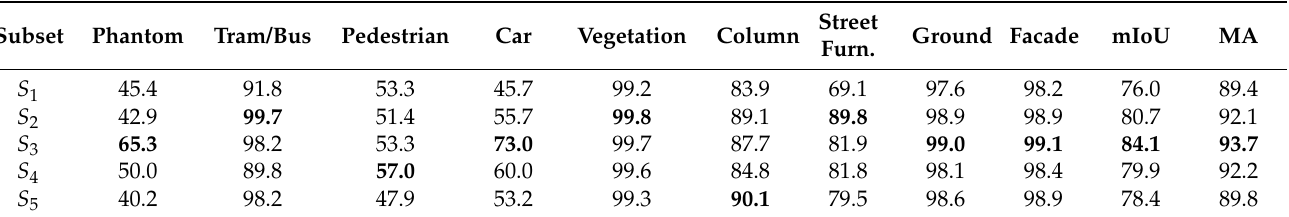
Table 3. Class-based results of RandLA-Net on subsets of SZTAKI-CityMLS. Highest values are marked as bold.